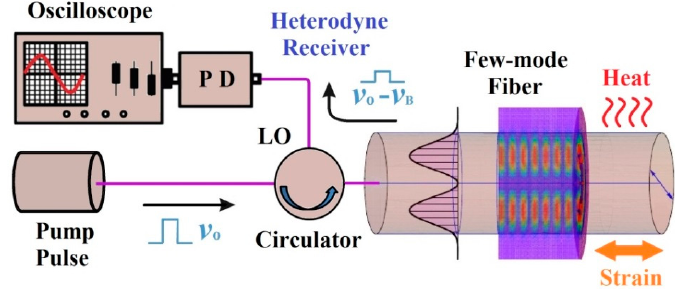
Figure 9. Fabrication and Characterization of a few-mode Brillouin sensing system.